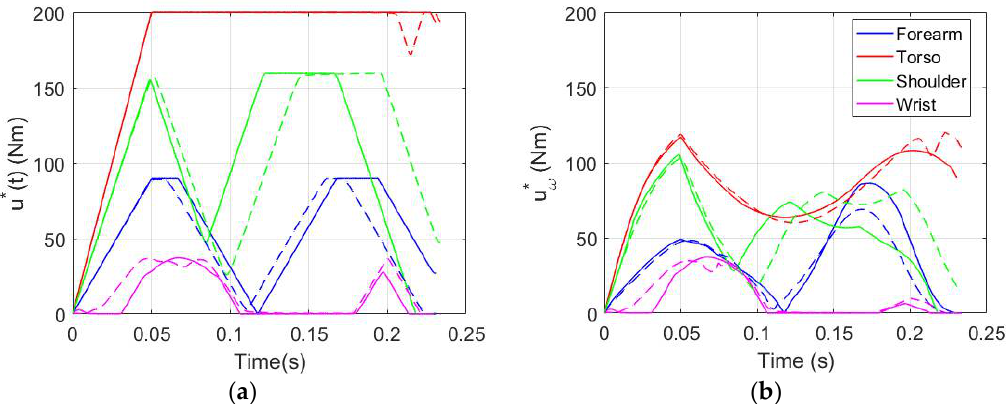
Figure 3. ( a ) Pre-scaled activation torque produced by each joint; ( b ) Velocity scaled optimal control, which represents the actual torque generated by the golfer.